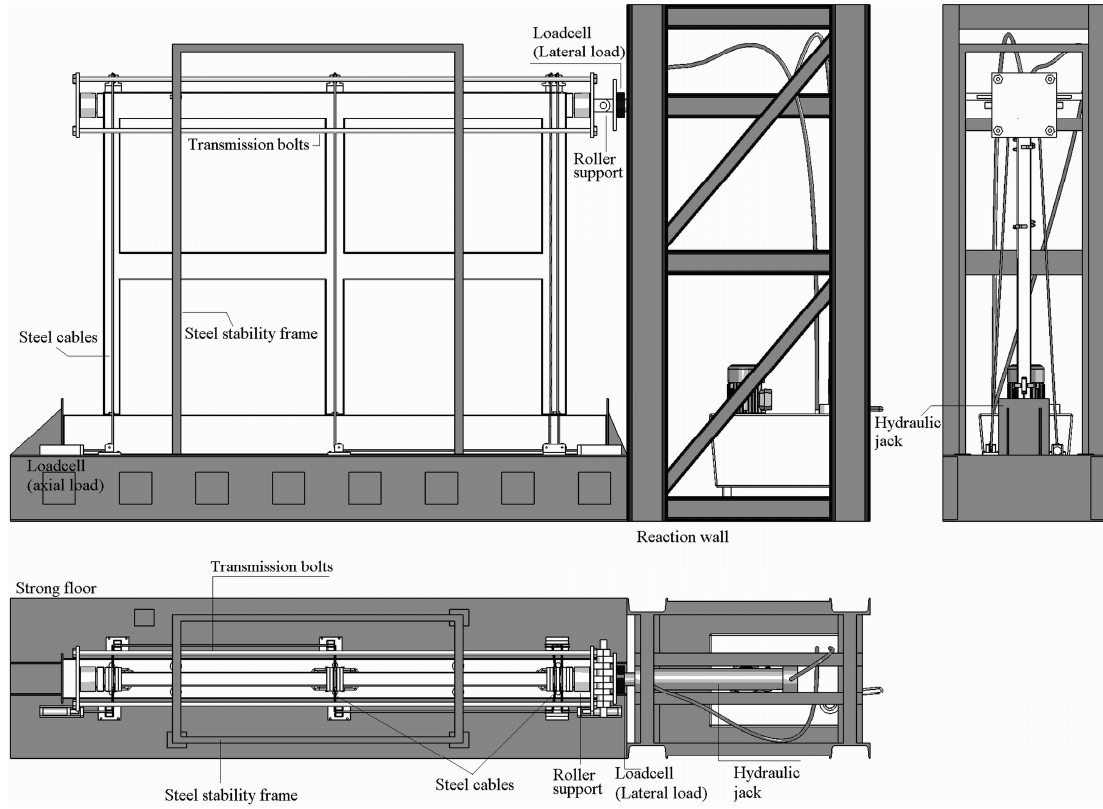
Fig. 3. Loading system of the 1st group tests (Arslan, 2007; Kaltakci, Figure 3. Loading system of the 1 st group tests (Arslan, 2007 – Kaltakci, 2008)